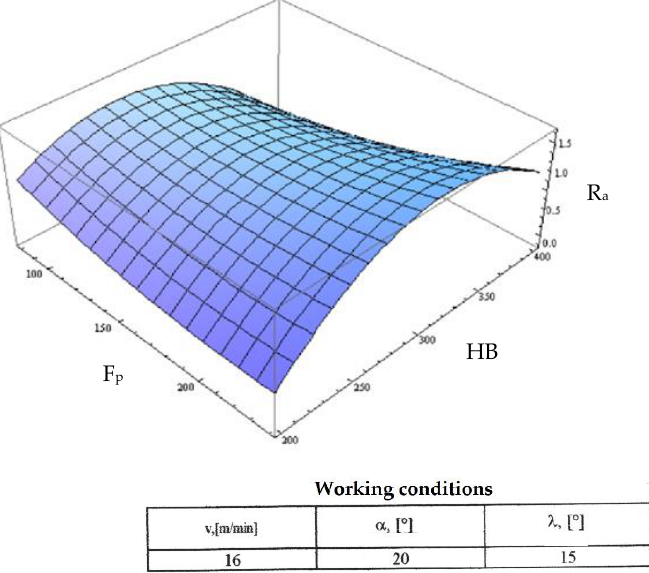
Figure 21. Influence of the hardness and contact force on roughness R a.